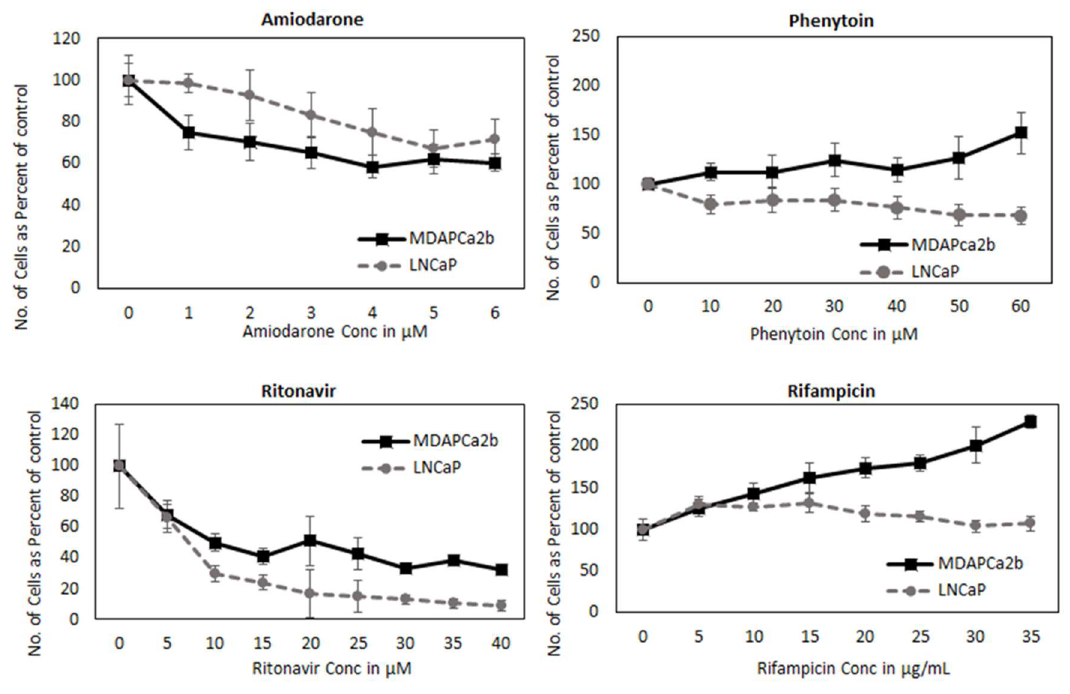
Figure 7. E ff ect of CYP3A5 inhibitor / inducer treatment on prostate cancer cell growth. LNCaP Figure 7 . Effect of CYP3A5 inhibitor/inducer treatment on prostate cancer cell growth. LNCaP and and MDAPCa2b cells were treated with a CYP3A inhibitors, amiodarone (0–6 µ M) and ritonavir MDAPCa2b cells were treated with a CYP3A inhibitors, amiodarone (0–6 µM) and ritonavir (0–40 (0–40 µ M); and CYP3A inducers Phenytoin (0–60 µ M) and Rifampicin (0–35 µ M) for 96 hours. The cell µM); and CYP3A inducers Phenytoin (0–60 µM) and Rifampicin (0–35 µM) for 96 hours. The cell growth was accessed using MTS growth was accessed using MTS assay .